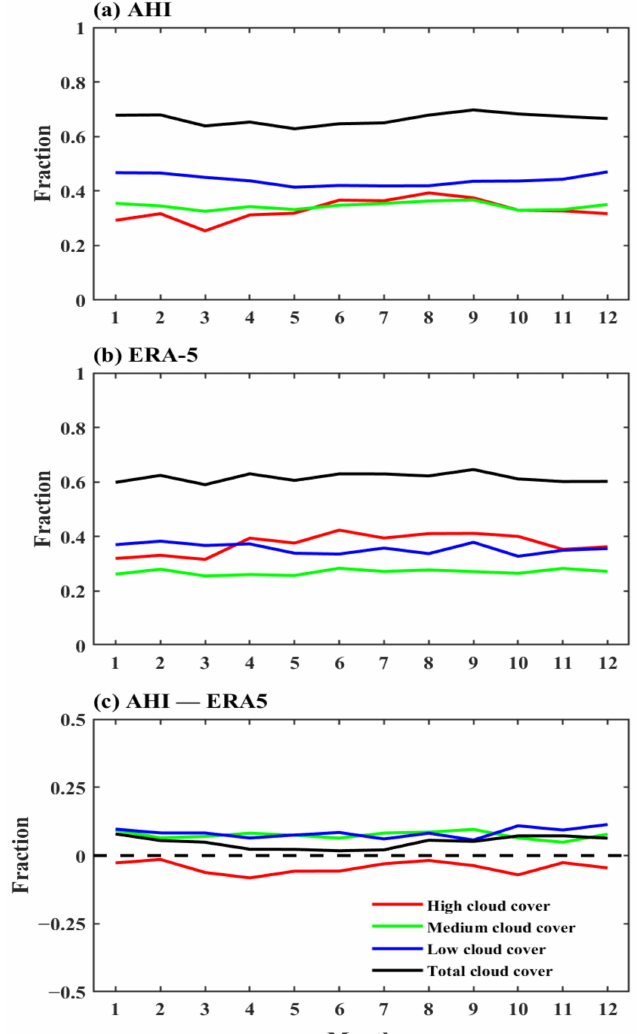
Figure 12. Monthly average total cloud cover (TCC) and layered cloud cover (LCC) from ( a ) the Advanced Himawari Imager (AHI) measurements, ( b ) ERA-5 reanalysis and ( c ) their